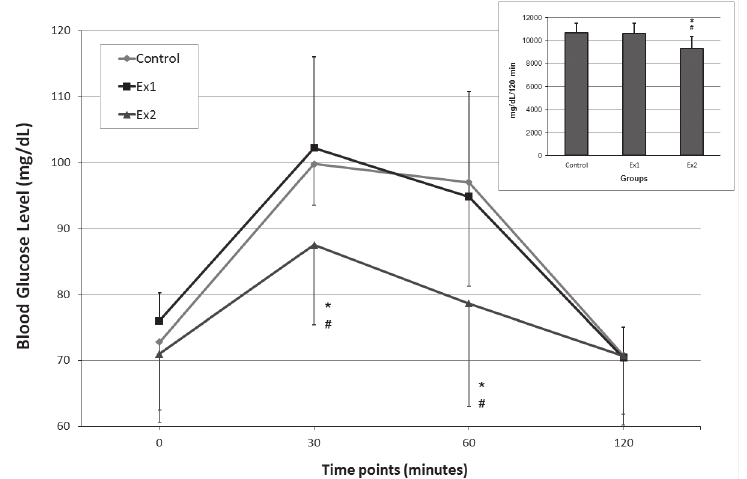
Figure 1 - Oral glucose tolerance test and area under curve from oral glucose tolerance test at day 17 of pregnancy of SPA control, Ex1 and Ex2 groups. Values are expressed as mean ± standard deviation (SD) with n=8 rats/group.